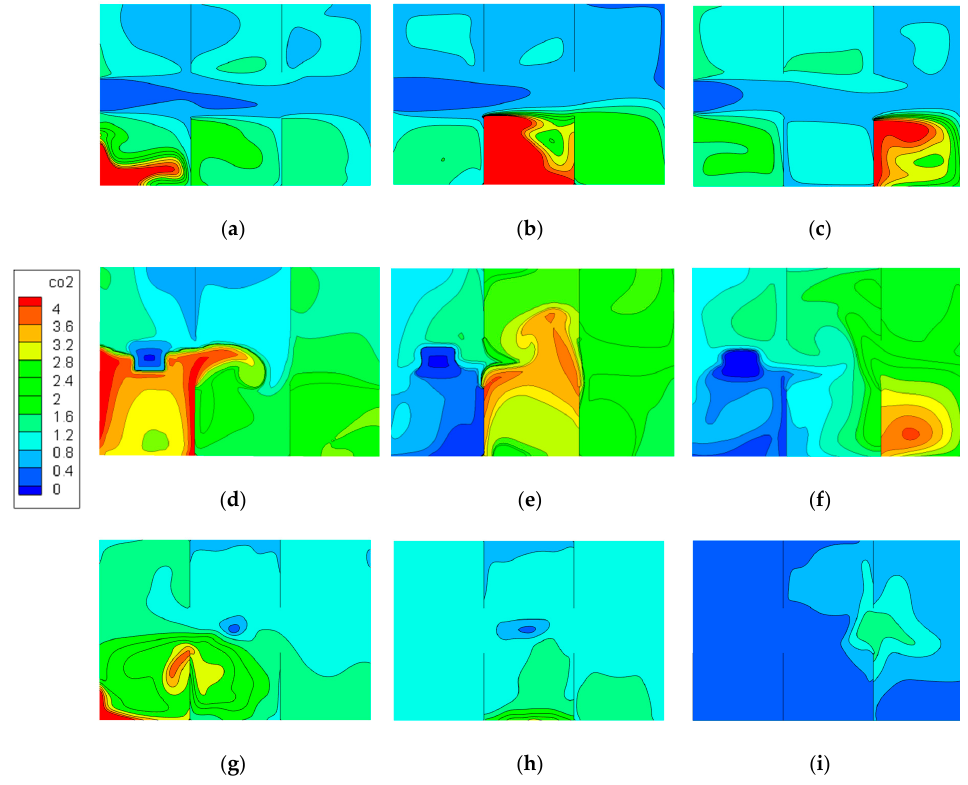
Figure 13. Distribution of CO 2 concentration at the height Z = 0.75 m: ( a ) Case 9, ( b ) case 10, ( c ) case 11, ( d ) case 12, ( e ) case 13, ( f ) case 14, ( g ) case 15, ( h ) case 16, ( i ) case 17.